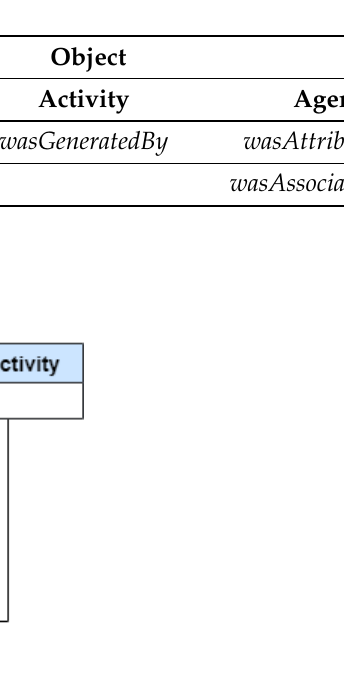
Figure 3. UML diagram for the PROV relationships supported in our prototype.